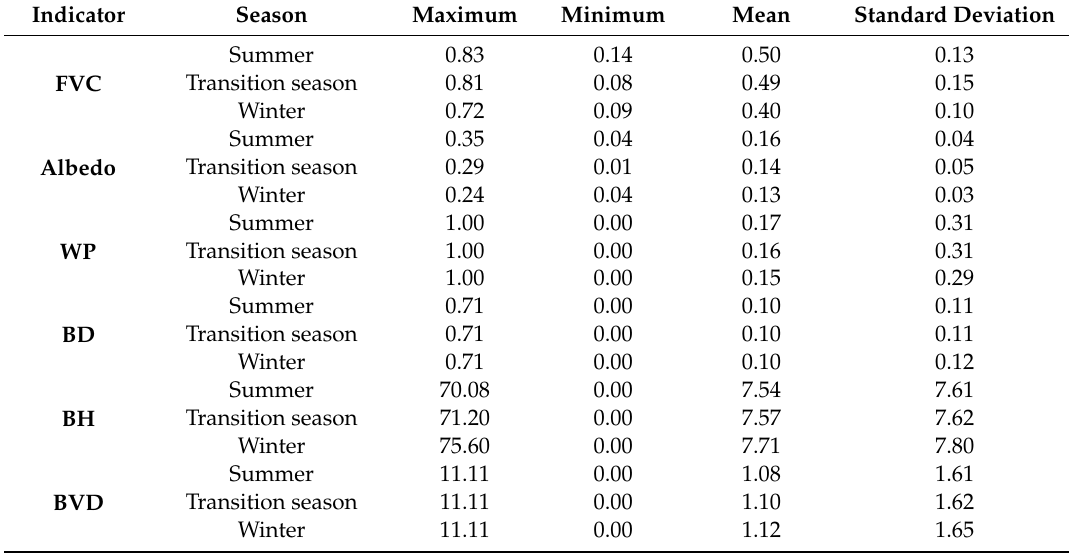
Table 3. The statistical summary of the selected landscape